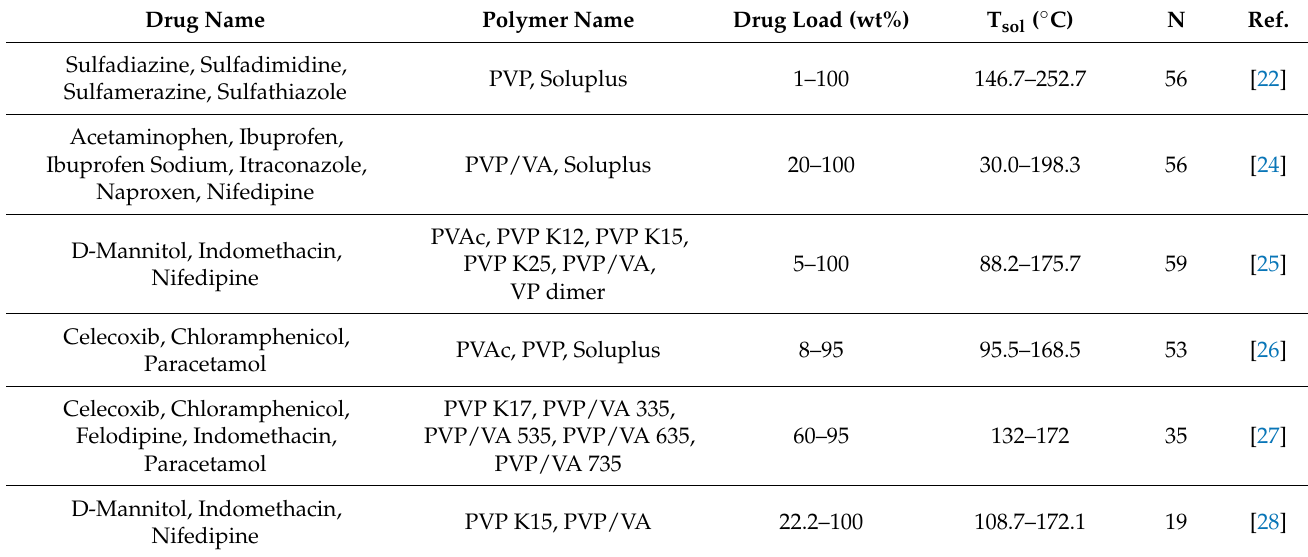
Table 1. Summary of the literature data for the solubility of drugs in